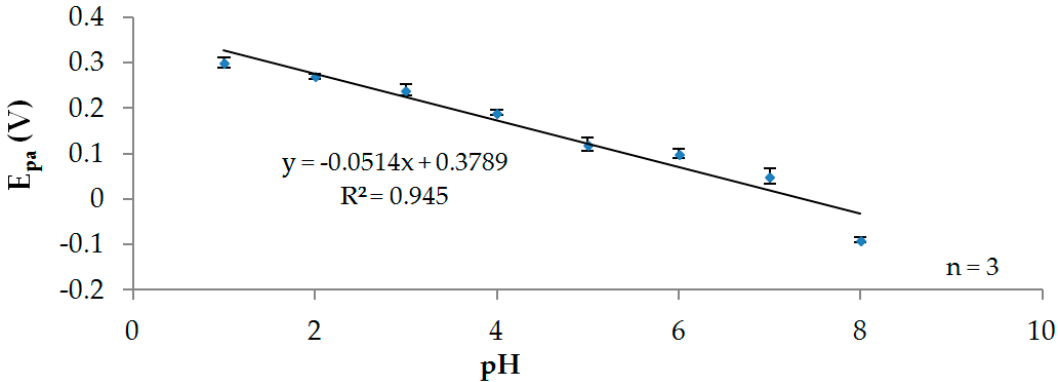
Figure 5. Dependence of anode potential (E pa ) with pH. Not visible error bars: when the symbol size is larger than the error bar.